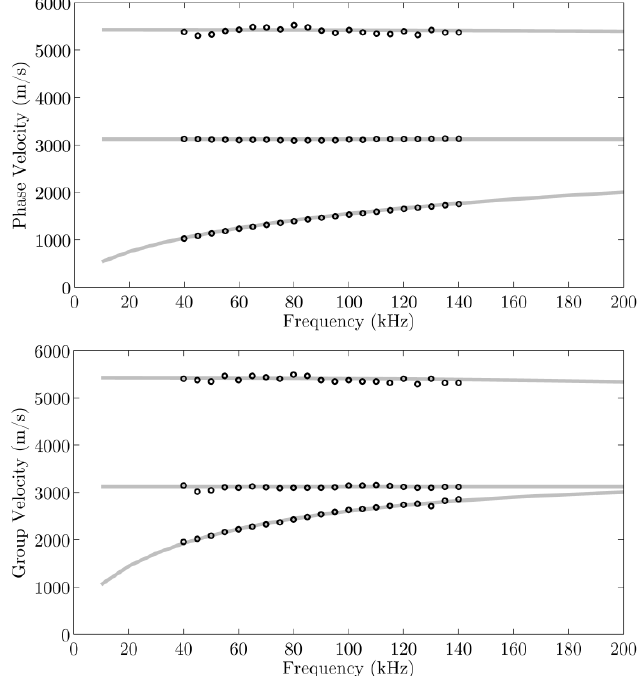
Figure 15. Phase velocity and group velocity created from experimental signals for 10 cm propagation distance (black circles) and theoretical values (grey lines).